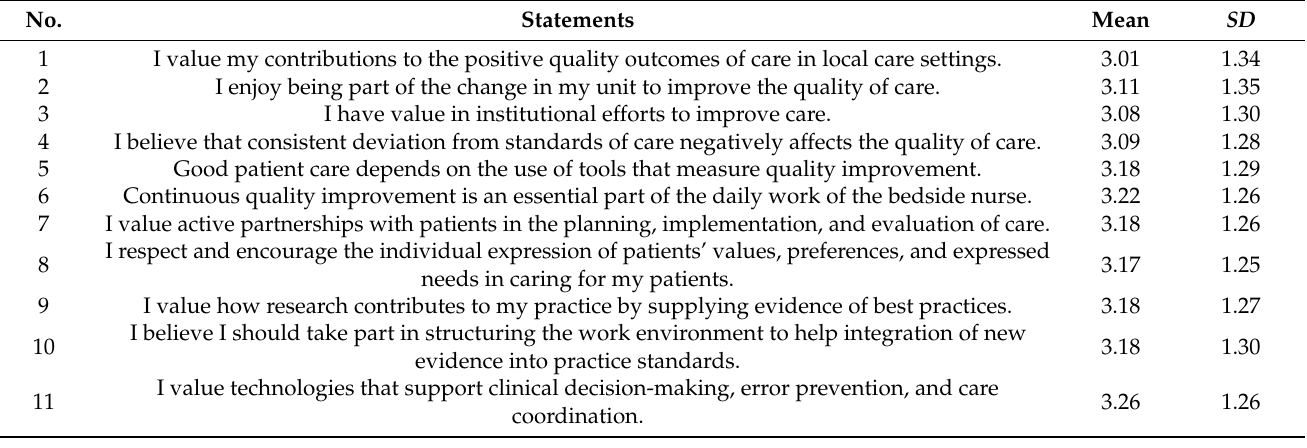
Table 2. Descriptive analysis of the Quality Improvement Nursing Attitude scale ( n =